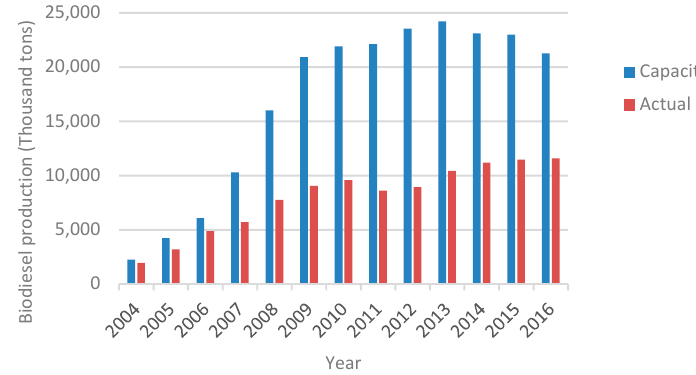
Figure 1. EU biodiesel production for the period 2004 to 2016 [17].